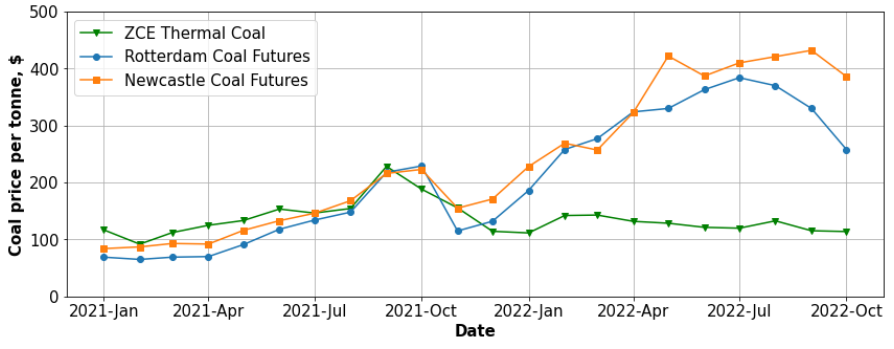
Figure 1. Trends and forecasts of world coal prices [1].